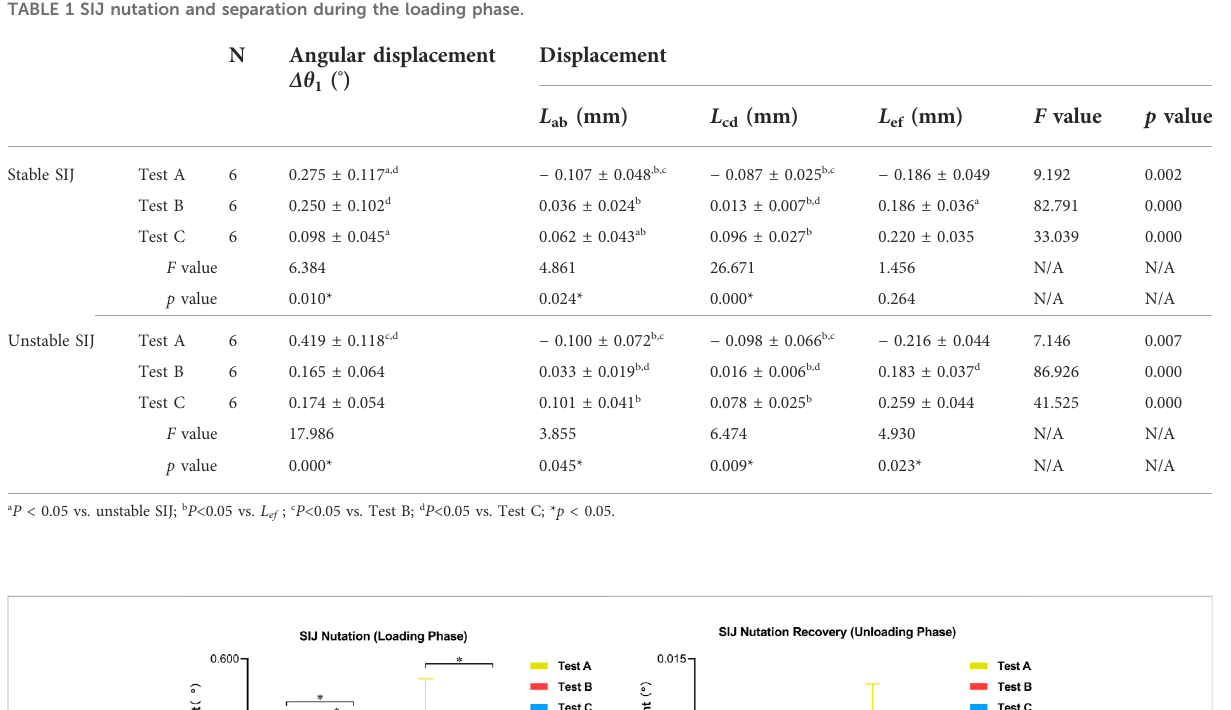
TABLE 1 SIJ nutation and separation during the loading phase.